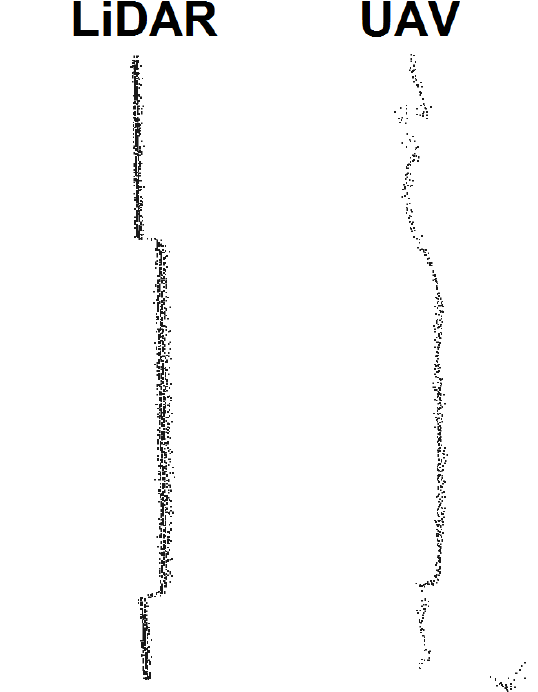
Figure 10. Typical cross section of a window in both a LiDAR point cloud and a point cloud from the